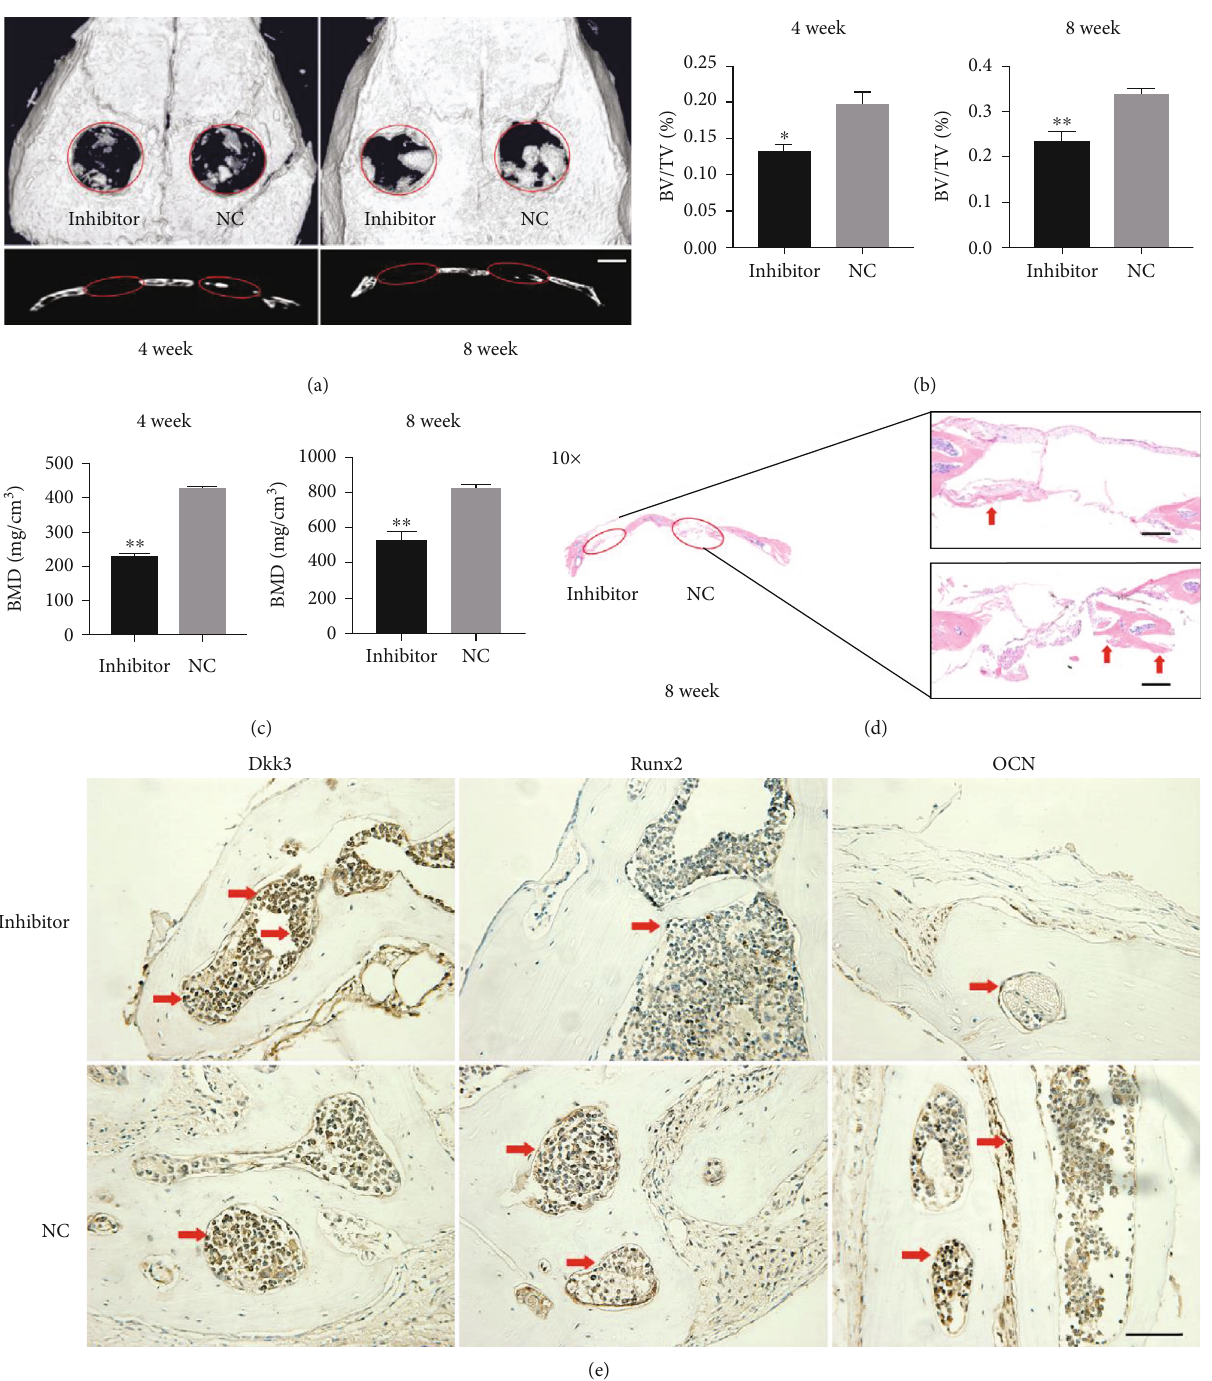
Figure 5: Knockdown of miR-129-5p suppressed bone regeneration. BMSCs transduced with lentivirus containing miR-129-5p inhibitor or control miRNA (NC) were loaded on matrigel sca ff olds, respectively, and then implanted into the defect of murine calvarium. Mice were sacri fi ced at week 4 and week 8 after implantation, and then, skull samples were collected for analyses. (a) Image with three-dimensional reconstruction (coronal and sagittal sections) from Micro-CT revealed di ff erent regeneration e ff ects in the miR-129-5p inhibitor group and the NC group. Quantitative analysis of the 3D images, including new bone volume relative to tissue volume (BV/TV) (b) and the bone mineral density (BMD) (c), was displayed. (d) Representative image of H&E staining (red arrow represented bone-like structures). (e) Immunohistochemical assessment of Dkk3, Runx2, and OCN in the miR-129-5p inhibitor group and the NC group (red arrow represented the positive cells). ∗ p < 0 : 05 and ∗∗ p < 0 : 01